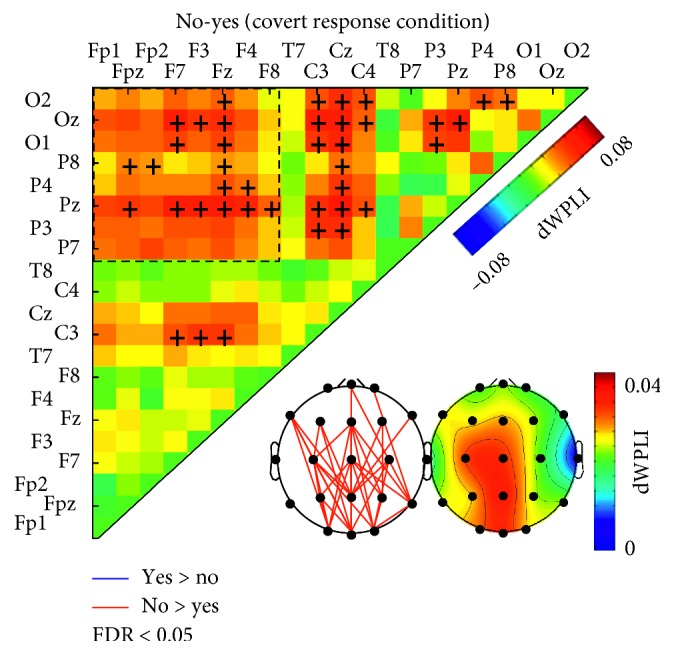
Adjacency matrix shows the differences of the dWPLI between “yes” and “no” (averaged within the significant TF cluster obtained in Figure 4(a)) for covert response. The black crosses denote significant differences between “yes” and “no,” determined by the mass-univariate method (FDR<0.05). Black dotted boxes indicate the electrode pairs between frontal and posterior (parietal and occipital) regions. Lower panels show the patterns of connections between electrode pairs corresponding to significant difference between “yes” and “no” (red: “no”>yes,” blue: “no”<“yes”) and topographical distributions of the “yes/no” difference in dWPLI.